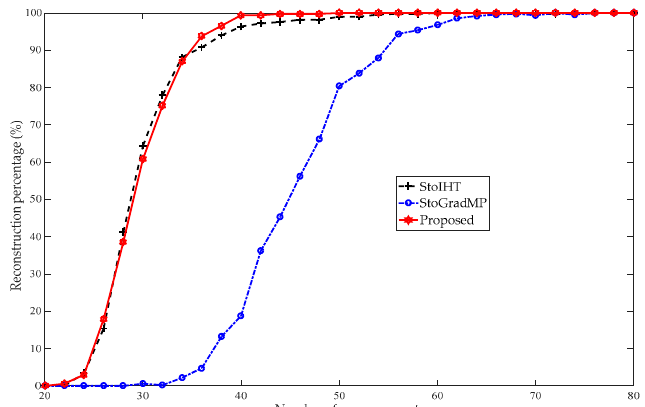
Figure 12. Reconstruction percentages of the StoGradMP and proposed algorithms ( d = 100, R = 1,3, κ = 0.2, m = 15 : 5 : 120, random low-rank matrix).